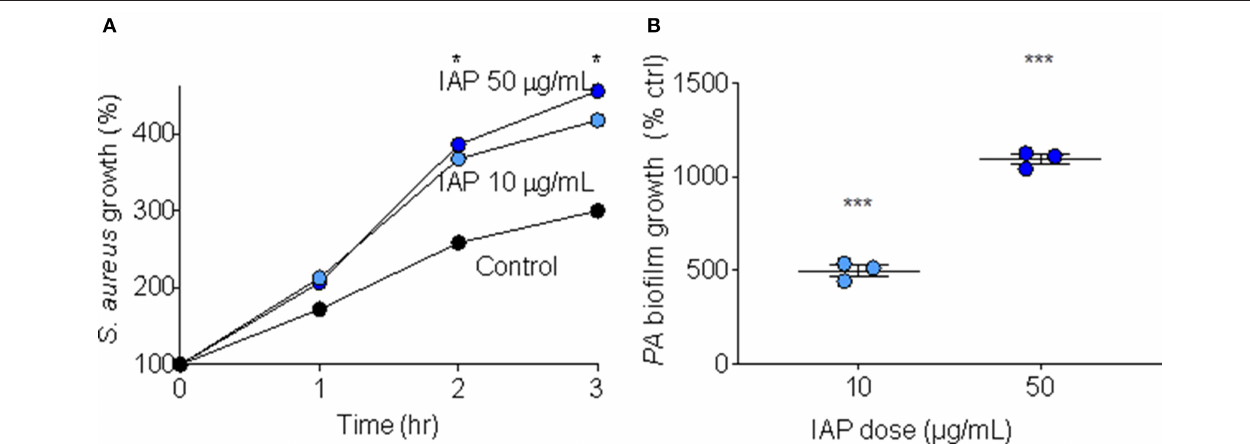
FIGURE 1 | Bacterial growth and biofilm formation in presence of NIST IAP. (A) IAP enhances S. aureus bacterial growth in minimal media after 2 and 3h, unpaired twotailed t -tests compared growth per condition to control ( n = 4 per condition), * p < 0.05 (B) P. aeruginosa biofilm growth in the presence of IAP particles at two doses (10 and 50 µ g/mL). Error bars represent means and standard error of the means. Differences in OD 550 of biofilm growth compared to vehicle control were compared using an unpaired two-tailed t -test *** p < 0.001.